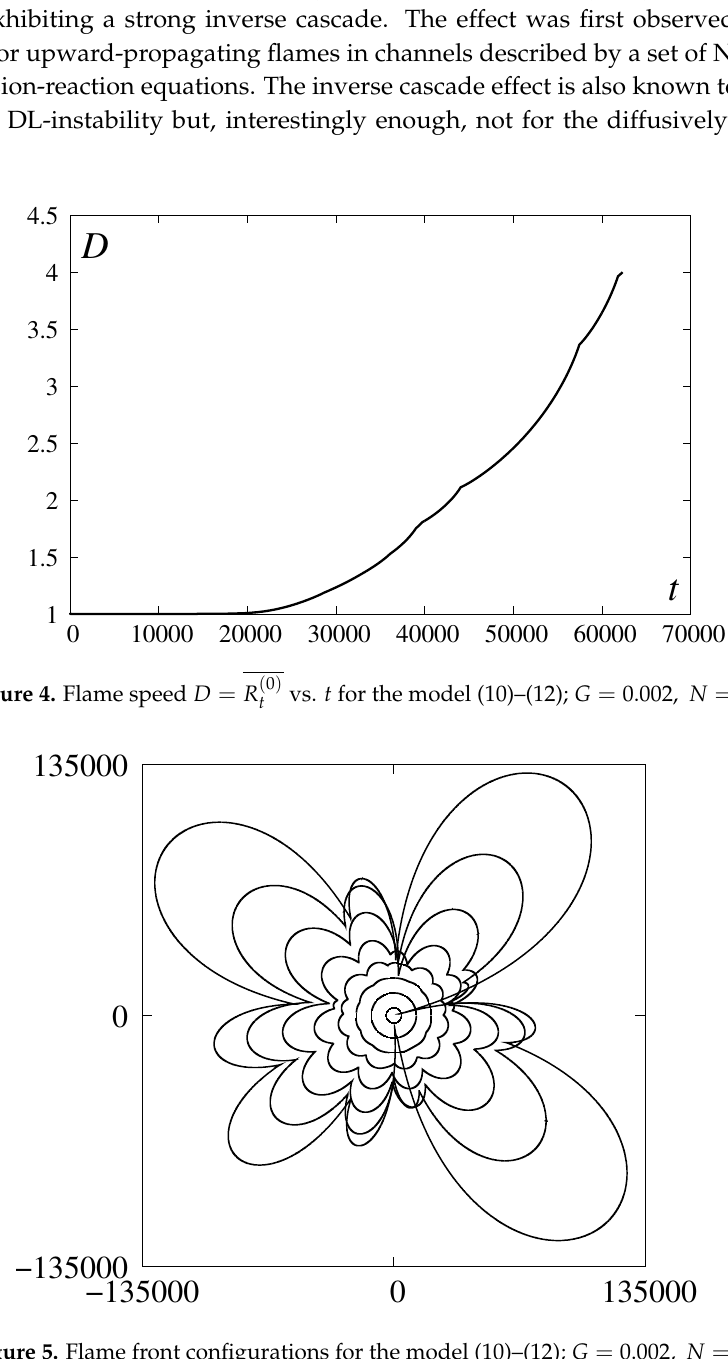
Figure 5. Flame front configurations for the model (10)–(12); G = 0.002, N = 2 15 . Simulation was terminated when rearward moving cusps reached the center ( r =